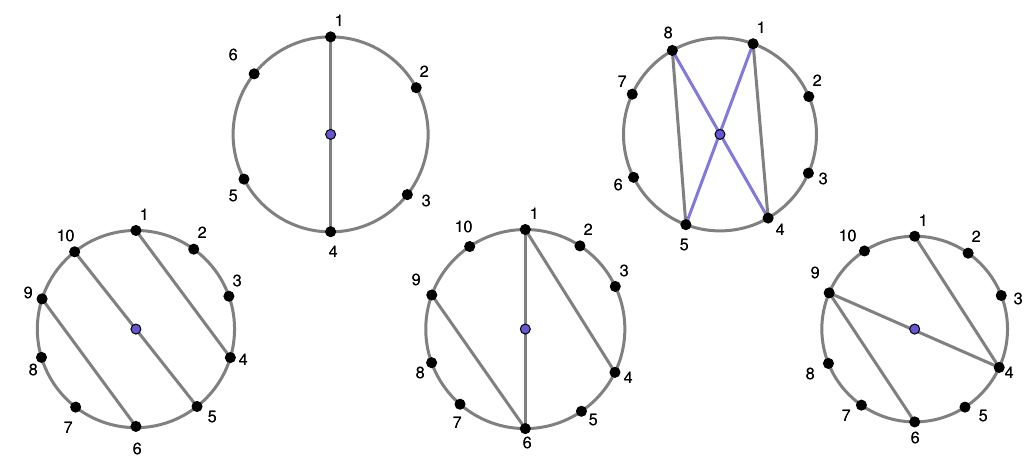
Figure 4 . Invariant quadrangulations for n = 1 ; 2 ;